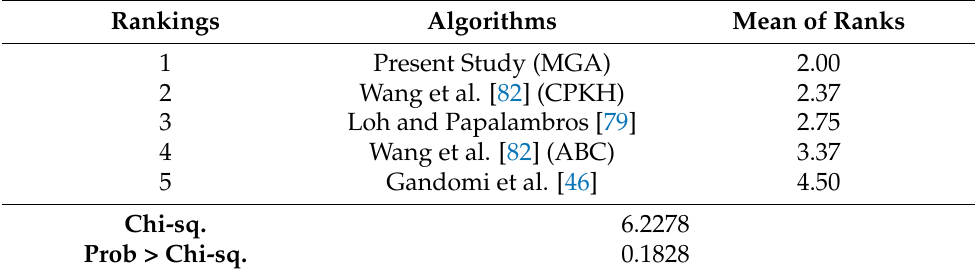
Table A18. Friedman statistical test results for the gear train design problem.